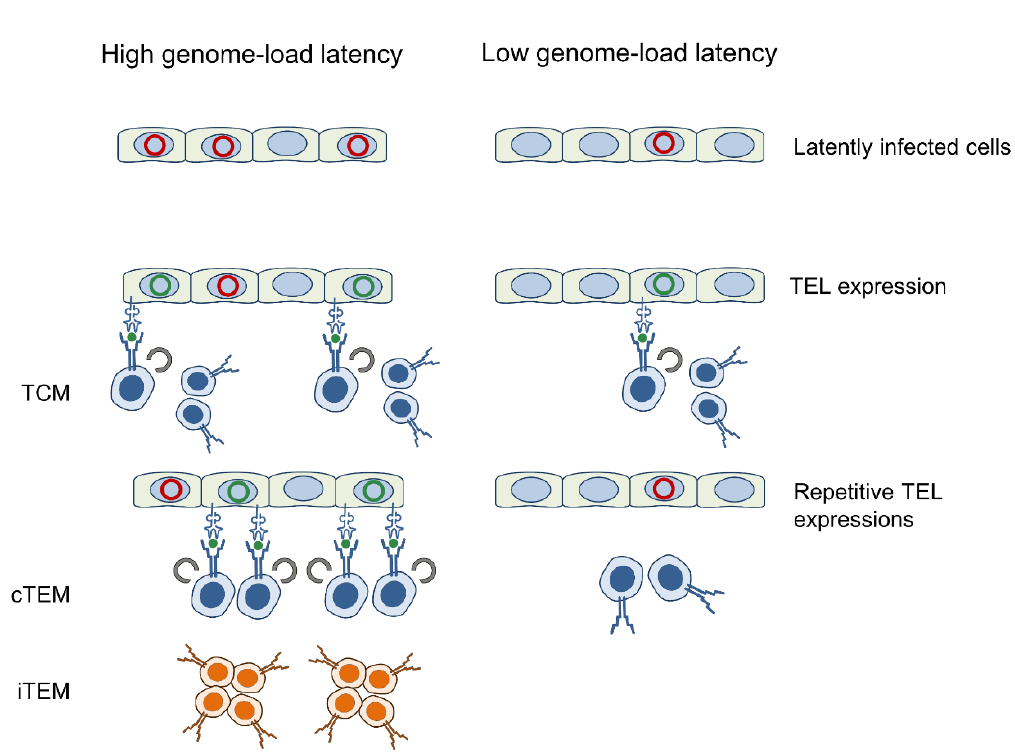
Figure S1: Verification of viral latency in spleen and lungs, Figure S2: Kinetics of m164- and IE1-epitope-specific functional avidity